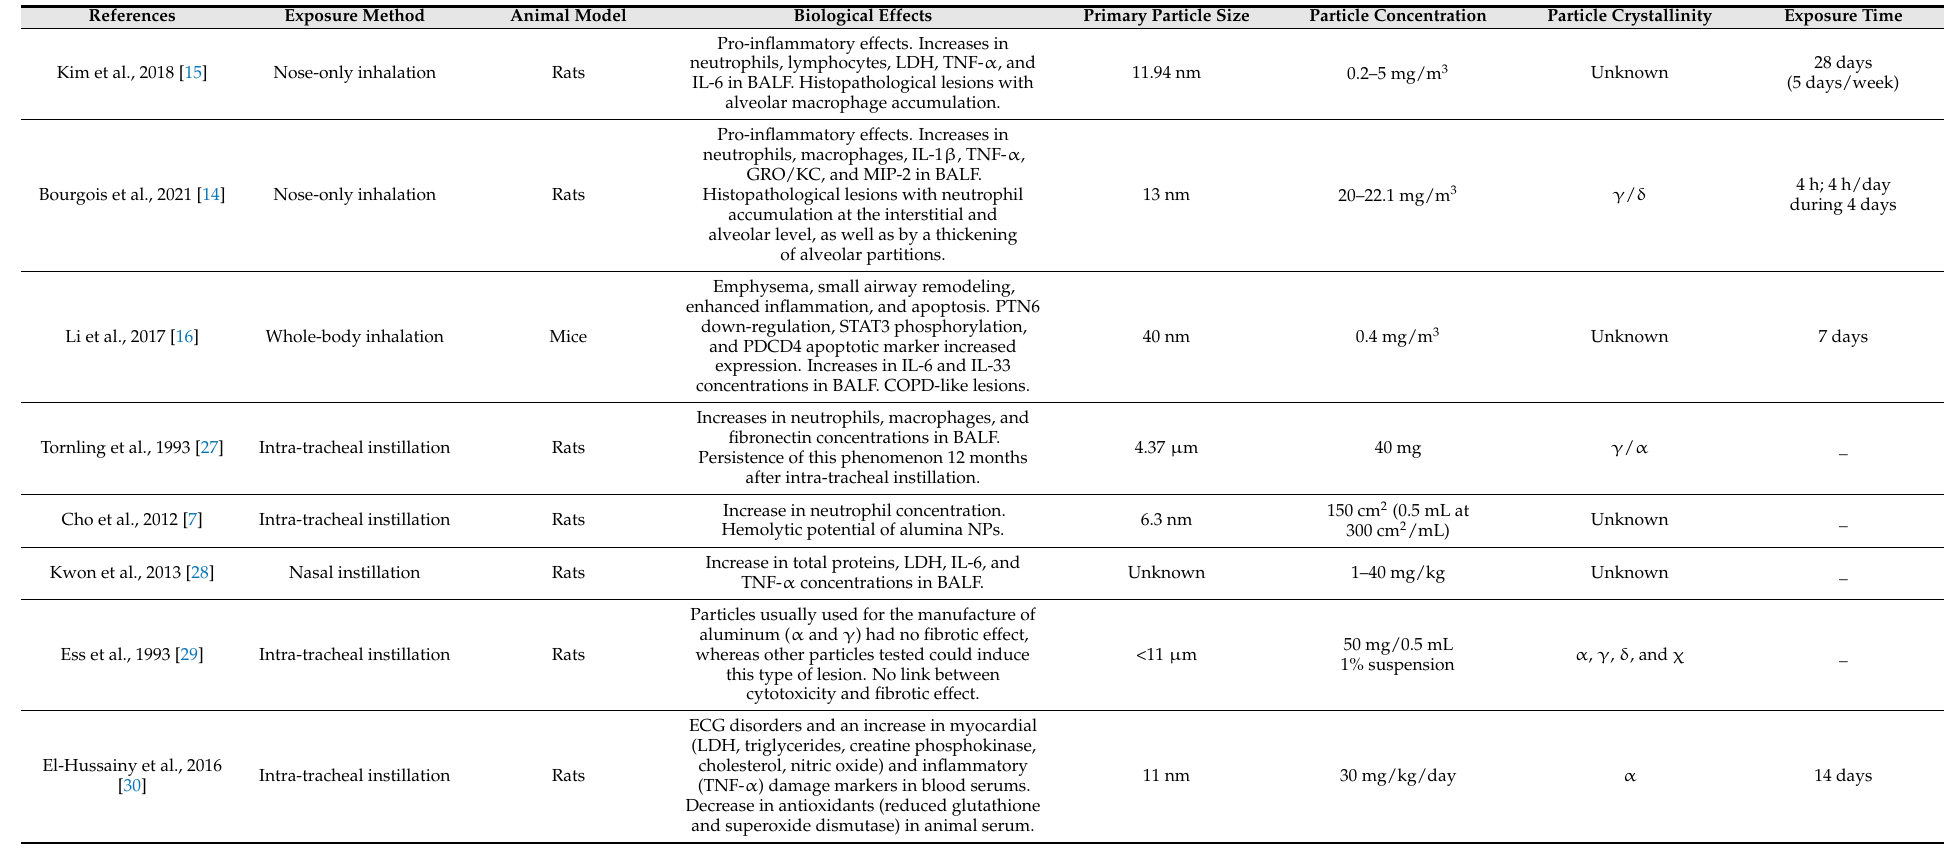
Table 2. Summary of animal